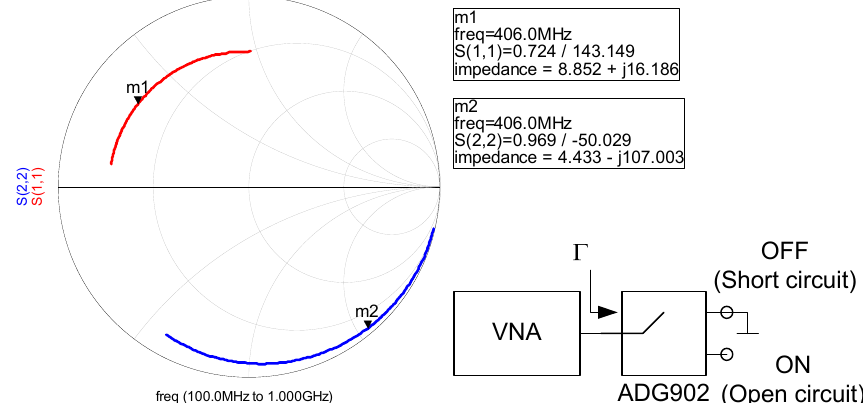
Figure 4. Measured reflection coefficients of the ADG902 switch (S11 state OFF, S22 state ON) as a